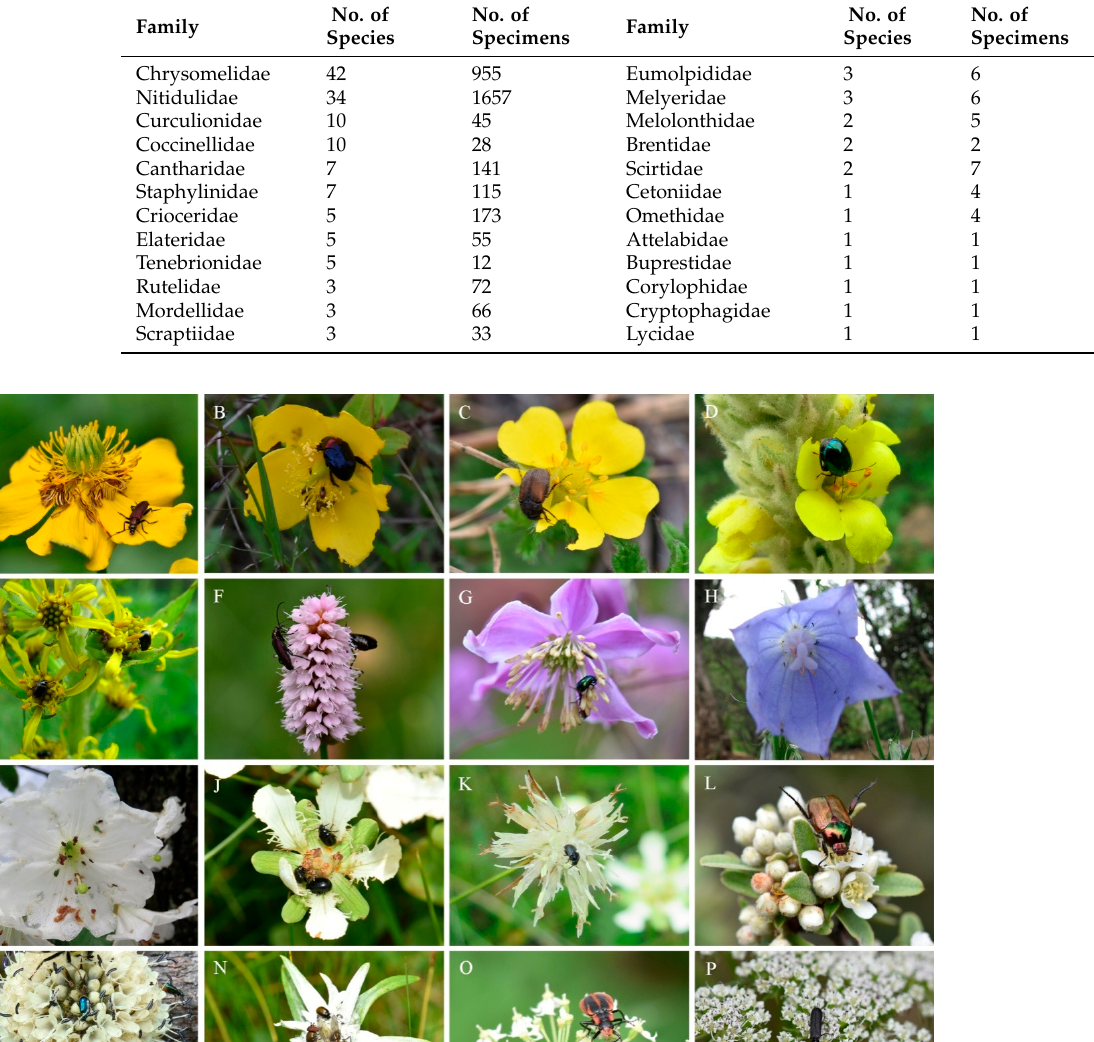
Table 1. Classification and number of specimens representing each beetle family.